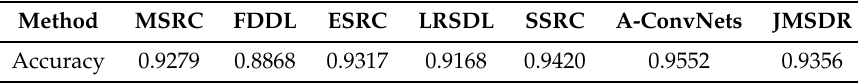
Table 4. The recognition accuracy on 10-class target by different methods.